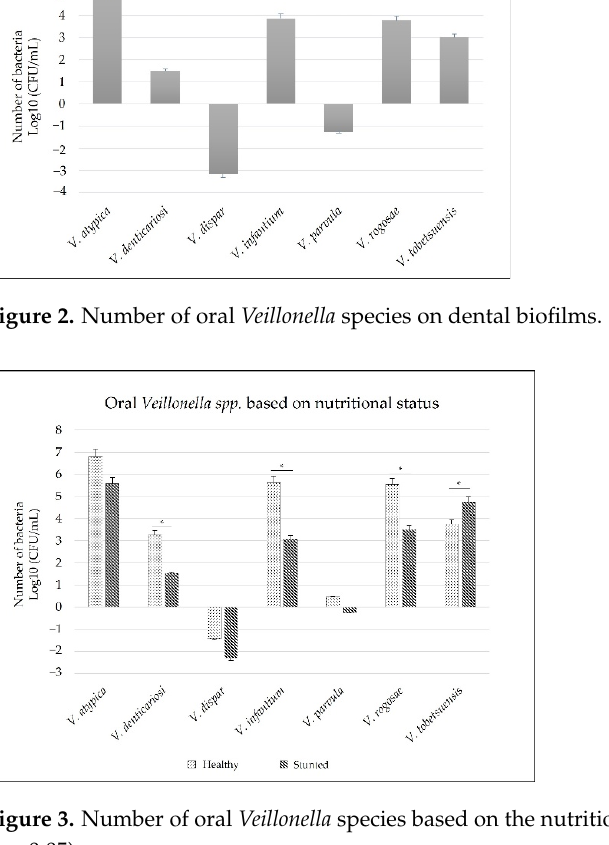
Figure 2. Number of oral Veillonella species on dental biofilms.